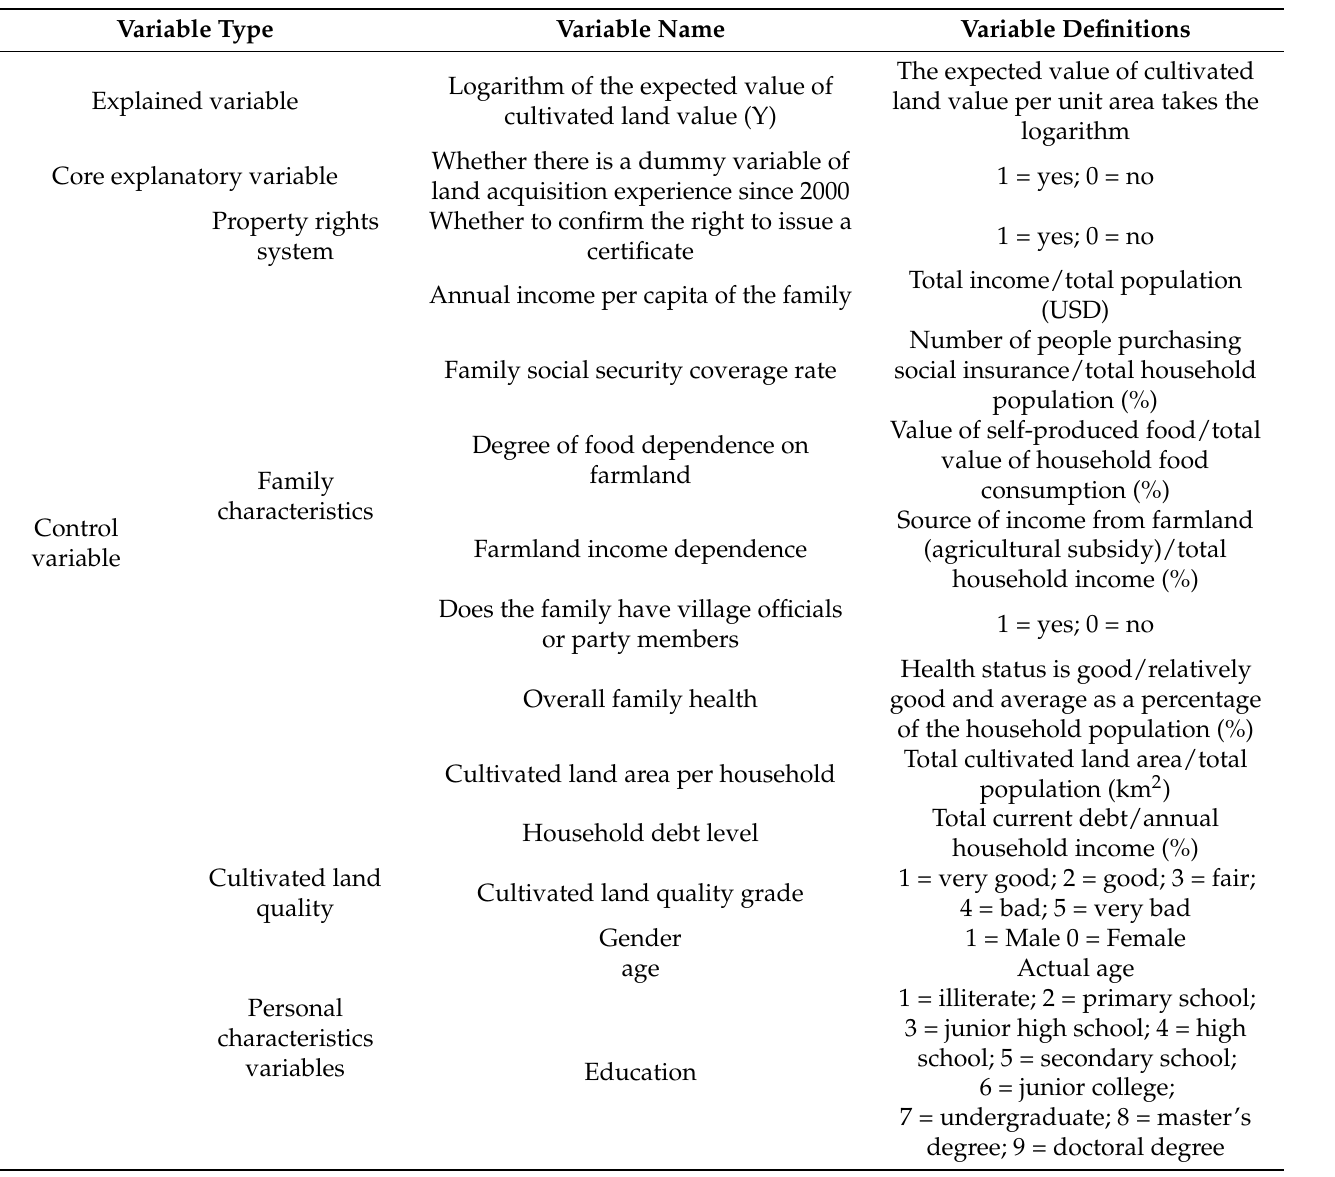
Table 2. Variable